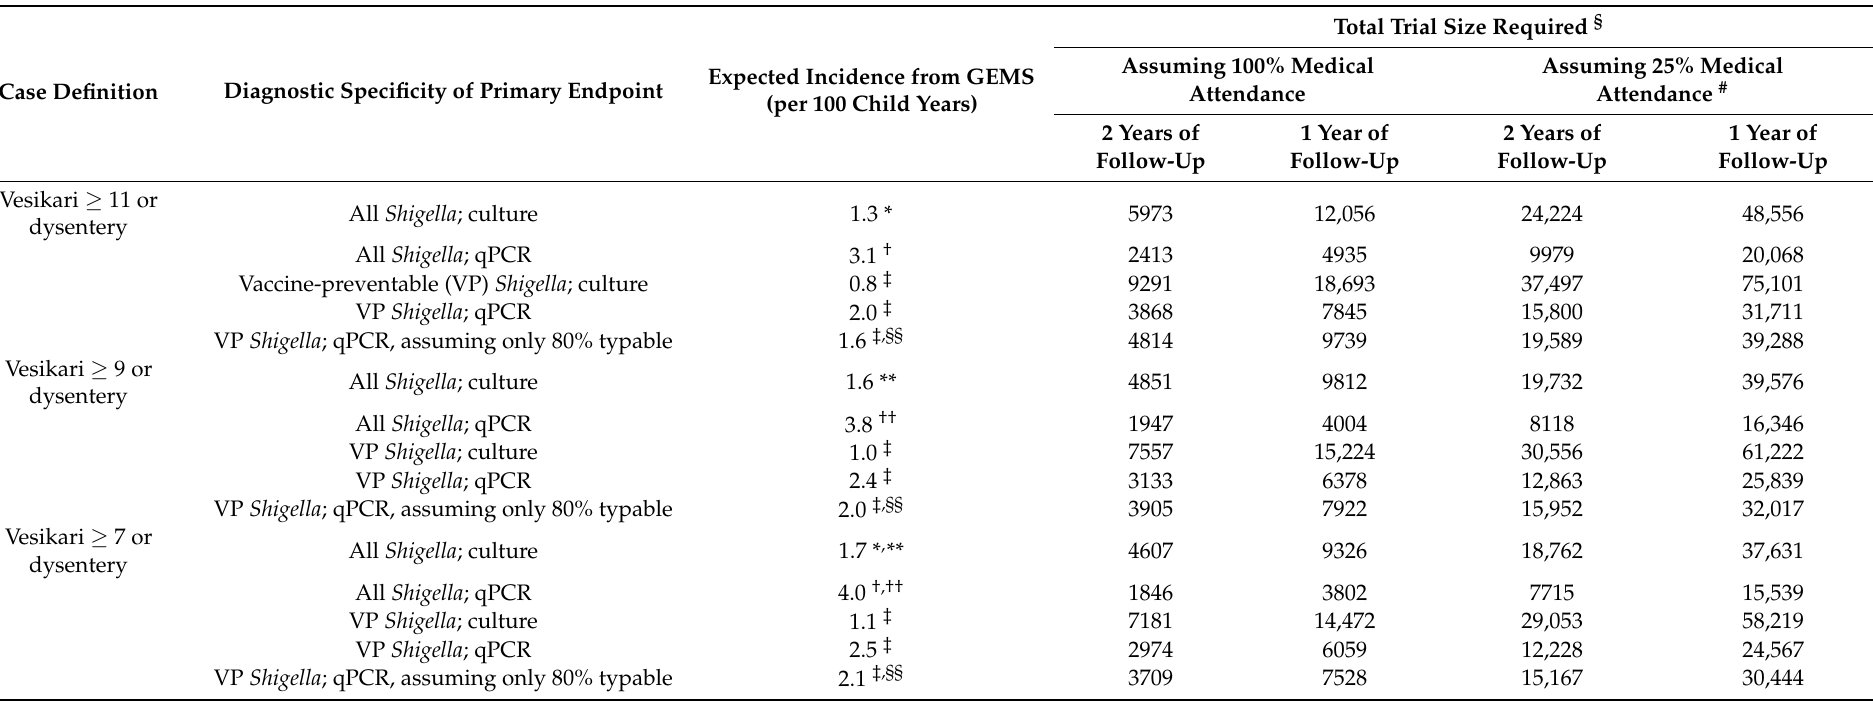
Table 3. Preliminary sample size calculations targeting efficacy with a lower 95% confidence interval bound of 20% for pediatric efficacy trials of Shigella vaccines based on data from the GEMS